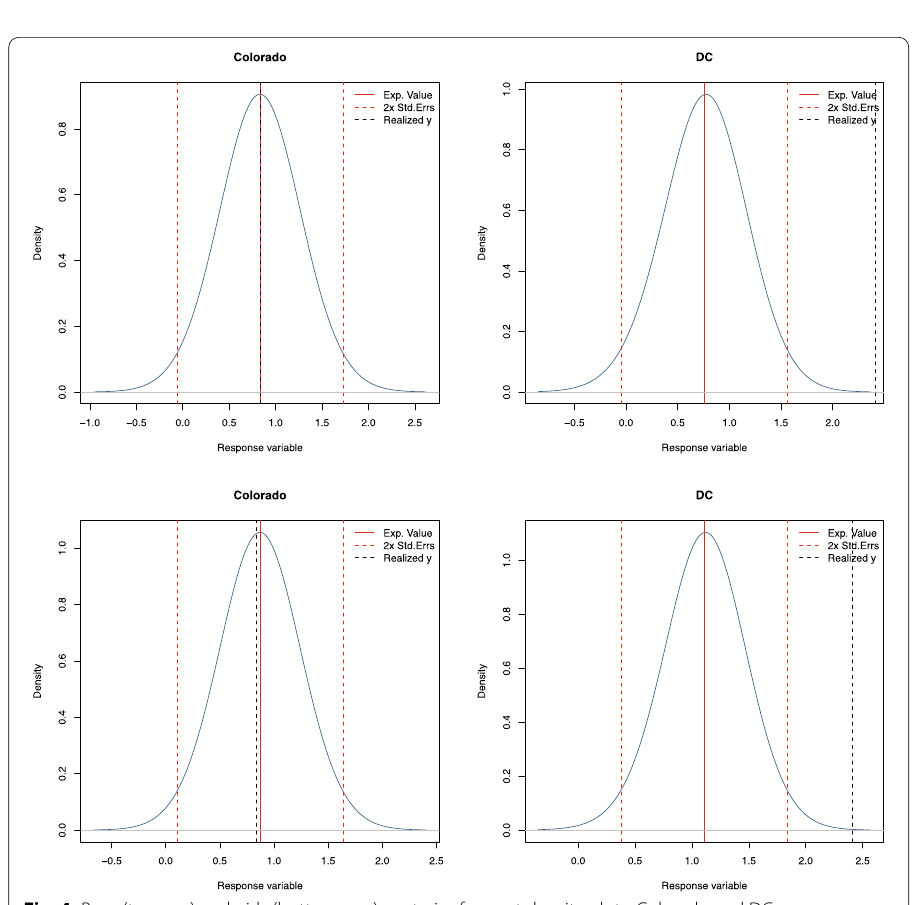
align with the actual growth rate. Large differences between the observed and predicted growth rates are indicative of the prediction model being incorrect for that state, that the state may be an outlier, or both. An example of the prediction model being a good fit to the actual growth rate can be seen in Fig. 4 for boys’ mathematics achievement, with the prediction of 8th grade growth in mathematics for Colorado. An instance in which the model is not predicting growth accurately is DC. In the situation of DC, it may be neces- sary to examine the data closely for possible problems, or examine different settings for